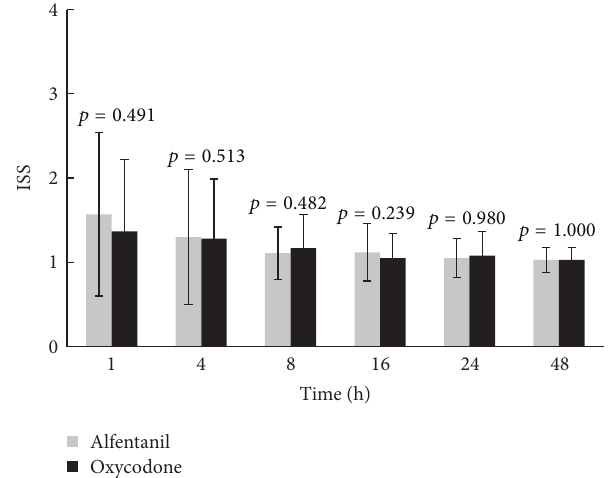
Figure 4: Inova Sedation Scale of patients between 1 and 48h after the operation. Means and standard deviation are shown. 𝑝 values were calculated by Mann-Whitney 𝑈 test. There were no significant differences between two groups ( 𝑝 value < 0.05). ISS: Inova Sedation Scale.